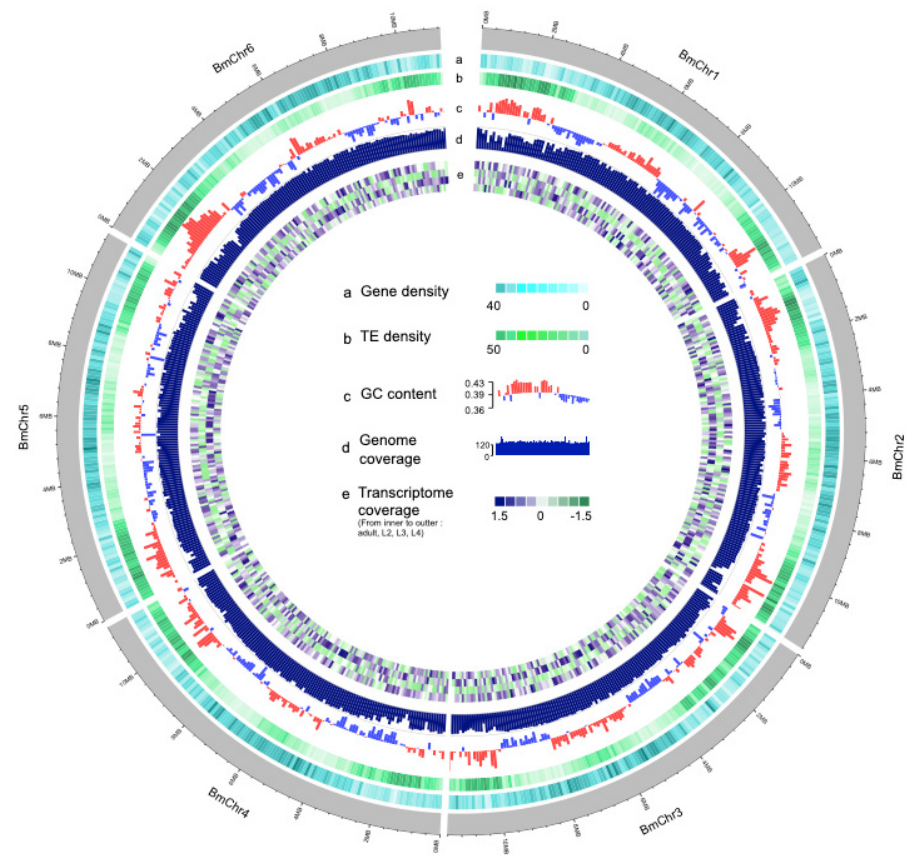
Figure 1. Circos view of the Bursaphelenchus mucronatus genome . The outer grey lanes depict circular representation of pseudo-molecules. The tracks indicate the following character with window size in 100 Kb: ( a ) the density of genes (darker color indicates more genes), ( b ) TE (Transposable element) density, ( c ) GC (Guanine and Cytosine) content, ( d ) genome coverage, ( e ) transcriptome coverage (from inner to outer indicate the di ff erent stage: adult, L2 (Second instar larvae), L3 (Third instar larvae), L4. (Fourth instar larvae). All values are normalized by Z-score).